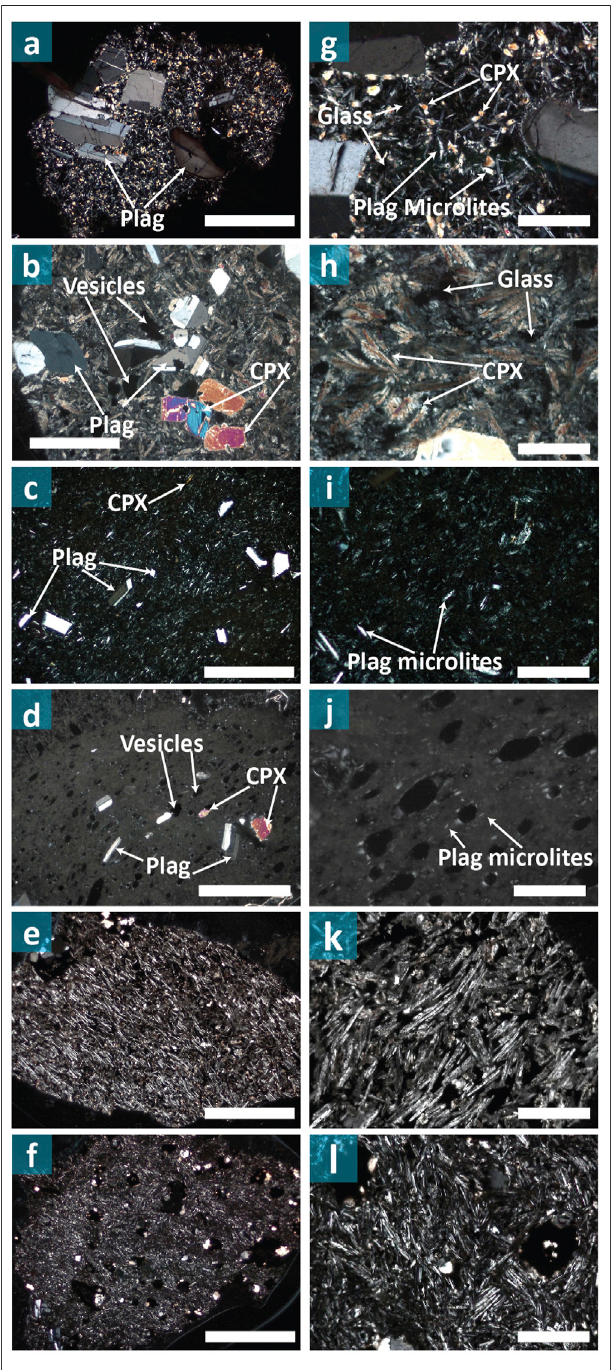
FIGURE 3 | Textural diversity of Embedded rock fragments within the Havre 2012 pumice raft. (A – F) Photomicrographs of rock fragments macro textures (A , G) denoting primary phenocryst phases and (G – L) groundmass textures correlating to the image in the left-hand column. (A , G , B , H) Group 1 Rock fragments display porphyritic textures and hypocrystalline groundmasses of variable mineral assemblages. (A , G) Example of a group 1 rockfragmentscontainingplagioclasephenocrystssetinaclinopyroxene-rich groundmass±plagioclaseandFe-Tioxides. (B , H) ExampleofaGroup1rock fragment containing phenocrysts of plagioclase and clinopyroxene set in a ( Continued )